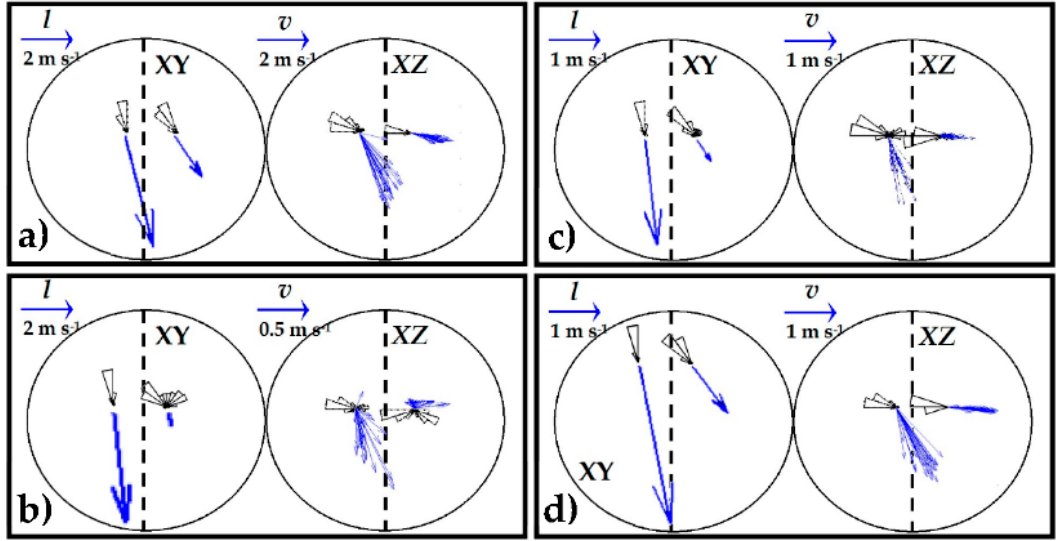
Figure 4. Representation of the airflow on the outer and inner face of the north side window facing windward. Tests 1 ( a ), 2 ( b ), 3 ( c ) and 4 ( d ). Representation of the global mean vector for the XY plane and minute mean vectors for the XZ plane.